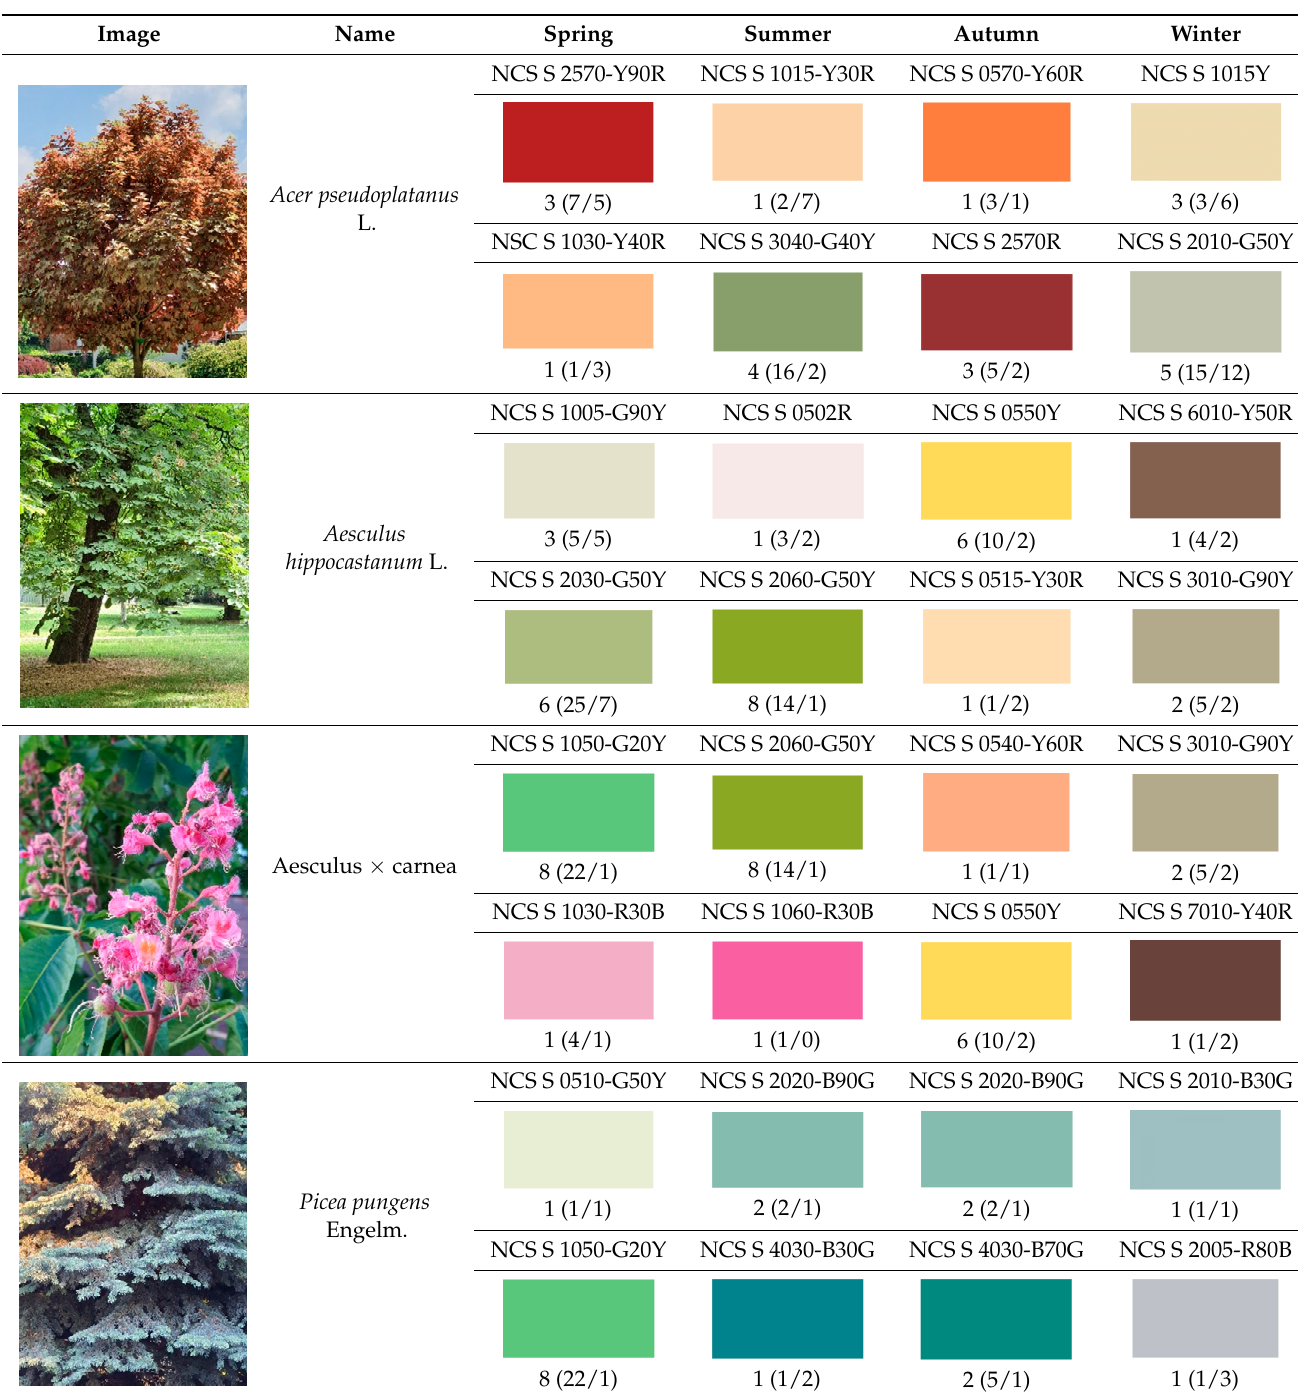
Table A2. Ninety-six color samples taken from shrubs and creepers identified in the research area. The numbers below the color sample provide the information how many times a given color appears in the table (how many times it appears in all natural samples / how many times it appears in the analyzed architectural objects).